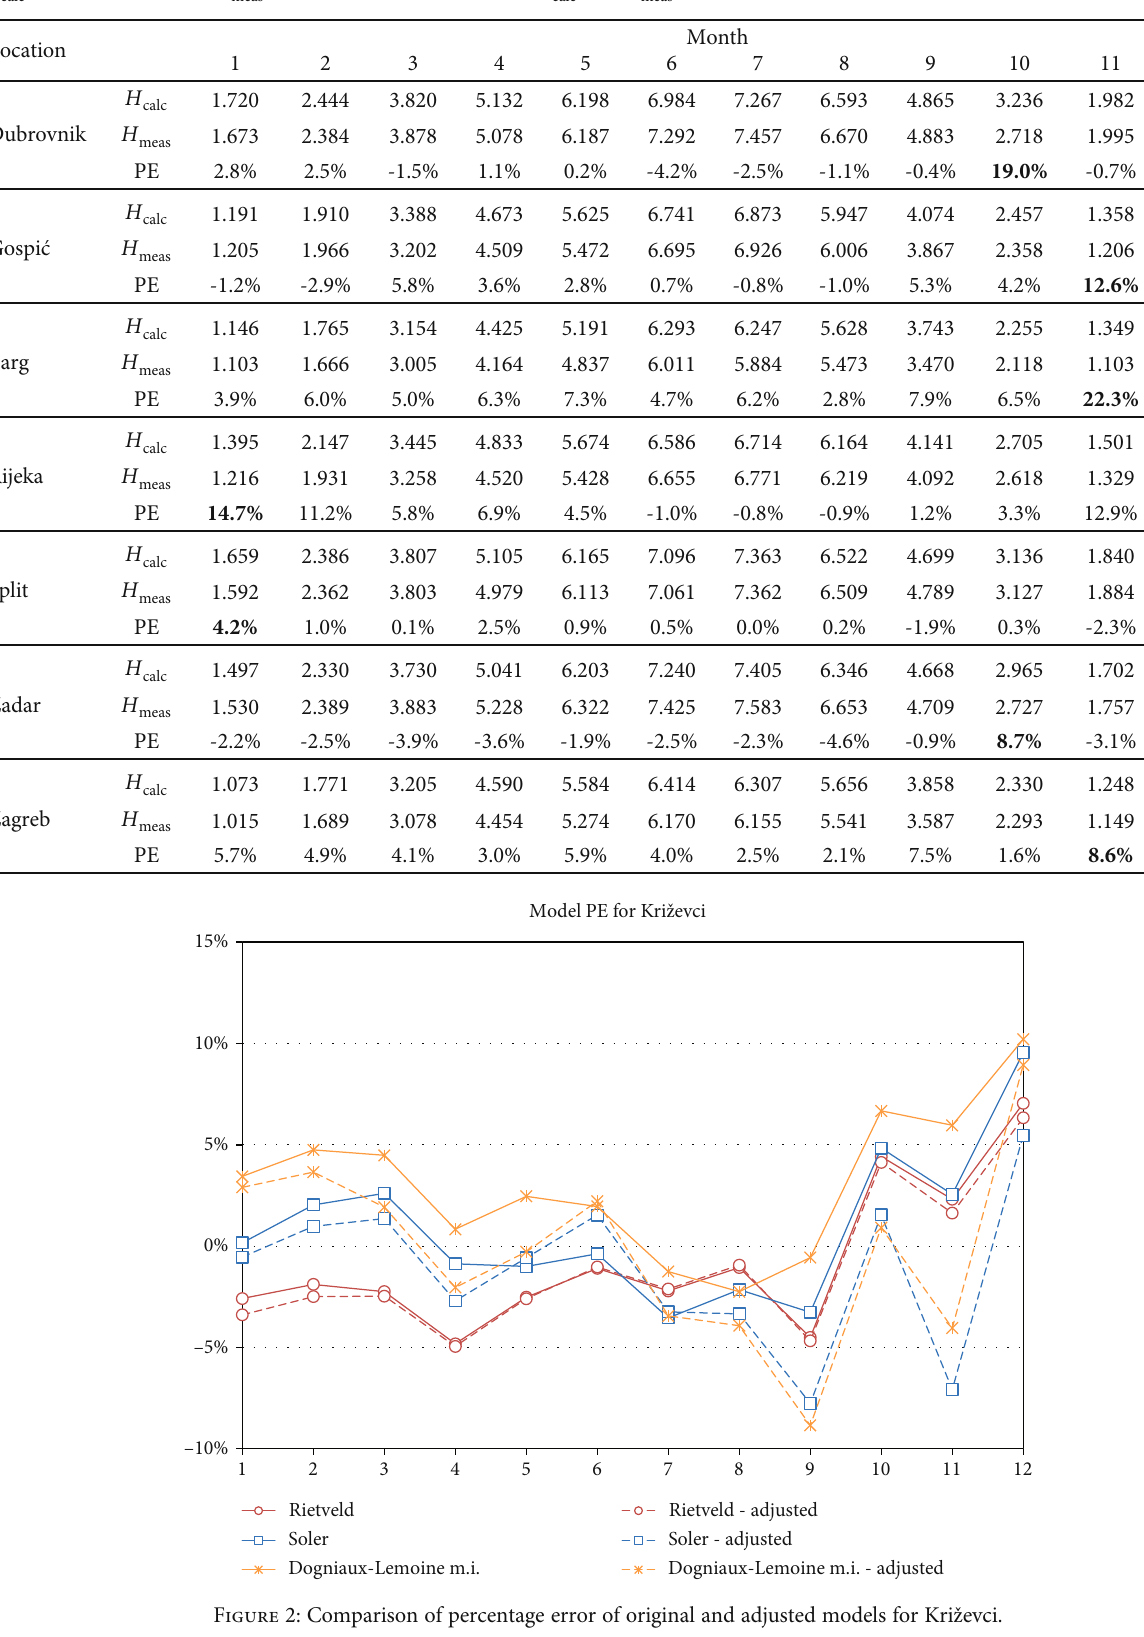
for seven Croatian locations. H meas